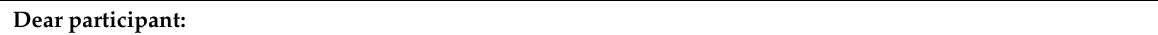
Table A1. Online